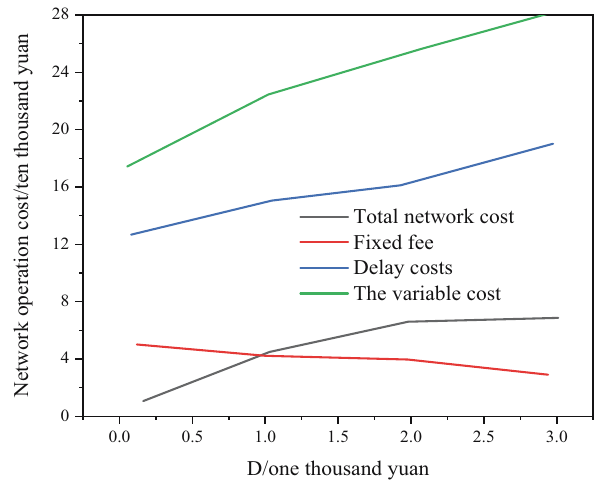
Figure 4: Computer simulation results of the weighting coe ffi cients of di ff erent unit grouping delay costs.